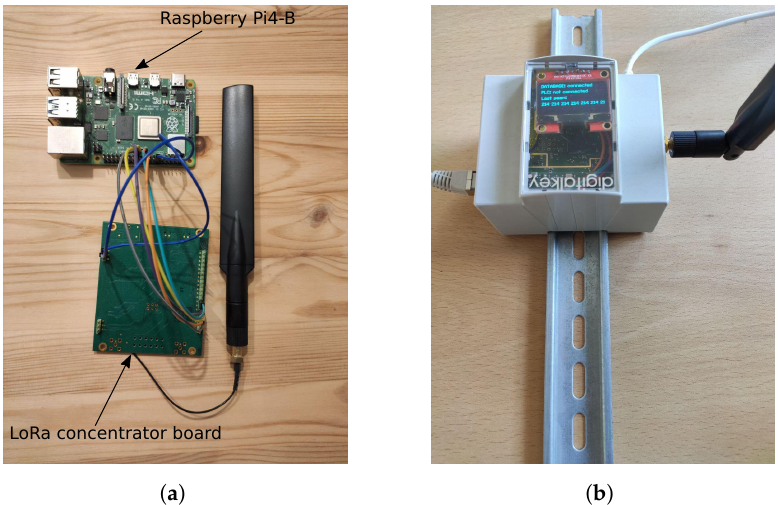
Figure 5. LoRa gateway and network server. ( a ) Spare GW/NS components. ( b ) Packed GW/NS com-